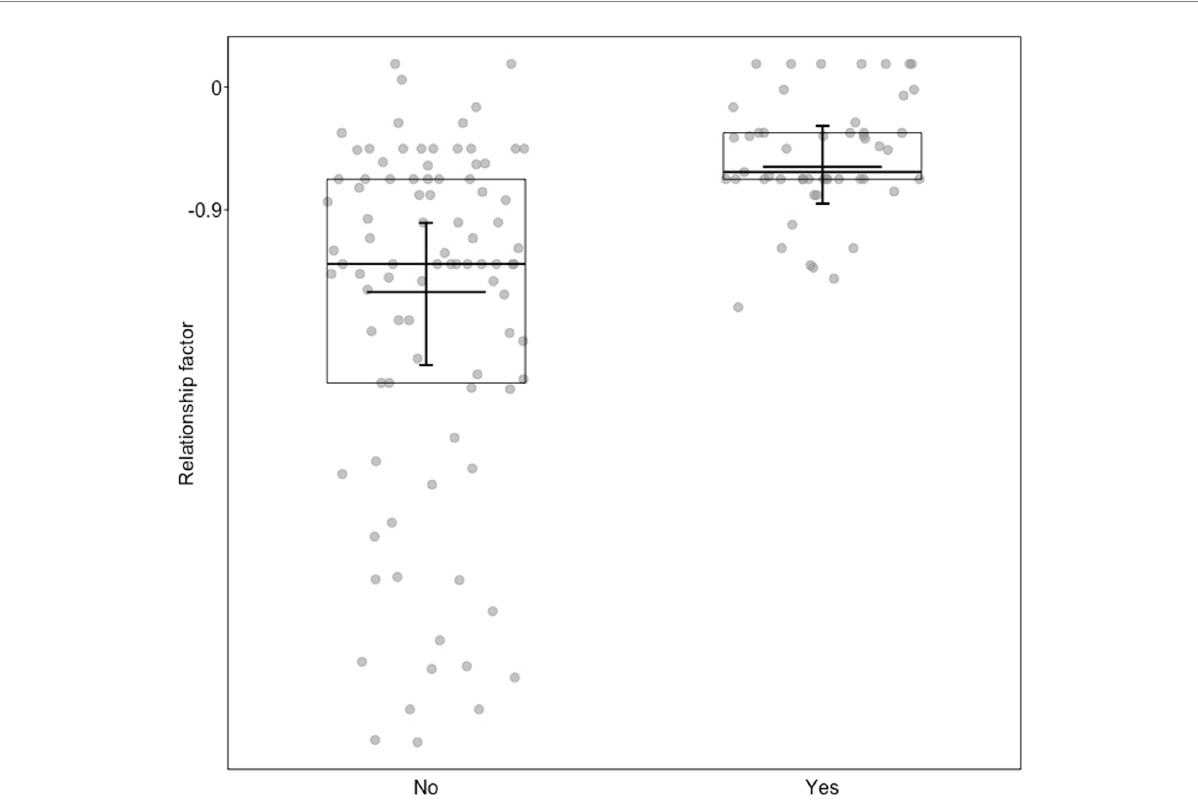
FIGURE 1 Relationship factor ( y -axis), as a function of if the trainer was hand-raiser (yes) or not (no). Dots show the individual data, horizontal lines with boxes medians and quartiles, and the short horizontal lines with error bars the fitted model and its confidence limits with all other predictors centered to a mean of zero. The relationship factor was comprised of ratings of how often the animal approaches, the strength of the bond from the trainer’s perspective, the strength of the bond from the animal’s perceived perspective, how friendly the animal is to the trainer, and how much the animal trusts the